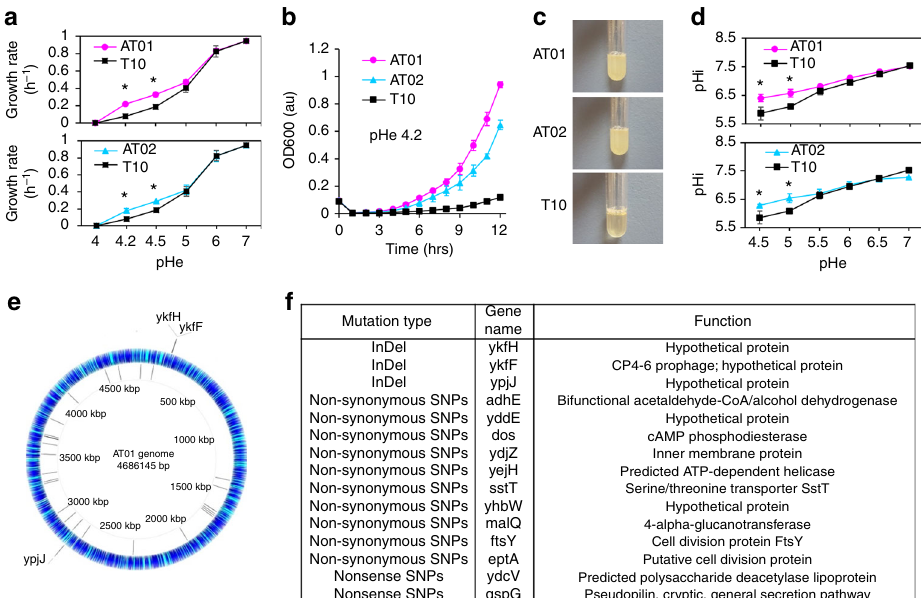
Fig. 5 Phenotype and genotype comparison of the evolved strains AT01, AT02, and wild-type T10. a Growth rates of AT01, AT02, T10 at varied pHe. b Growth pro fi les of AT01, AT02, T10 in M9 medium at pHe 4.20. c Culture turbidity of AT01, AT02, T10 grown in M9 medium at pHe 4.20 for 18 h. d pHi of AT01, AT02, T10 at different pHe. Student t -test: asterix = P < 0.05. e Mutations in the AT01 genome compared to the DH10B reference. The middle blue ring represents coding sequences (CDSs) in the reference DH10B genome. The arcs in the inner ring represent single-nucleotide polymorphisms ( SNPs ) in AT01 compared to the reference. The arcs in the outer ring show coding sequences (ykfH, ykfF, ypjJ) with insertion or deletion mutations compared to the reference. f List of modi fi ed CDSs in AT01. The data represent the mean of three biological